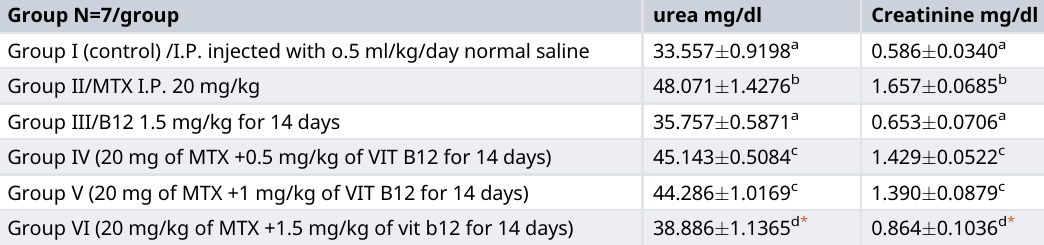
Table 2. Effect of cyanocobalamin on plasma urea and creatinine level. Group N=7/group